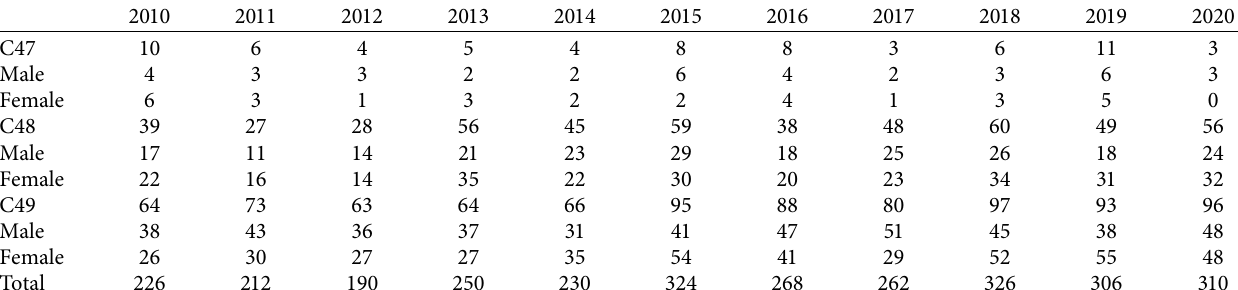
Figure 3: Evolution of neoplasms from 2010 to 2020 by ICD-10 codes (ICD-10: International Classifcation of Diseases, 10th Revision; C47: malignant neoplasm of peripheral nerves of the head, face, and neck; C48: malignant neoplasm of the retroperitoneum; C49: malignant neoplasm of other connective and soft tissues; C85: other specifed and unspecifed types of non-Hodgkin’s lymphoma; C92: myeloid leukemia). Table 4: Mortality per year due to STS by gender.